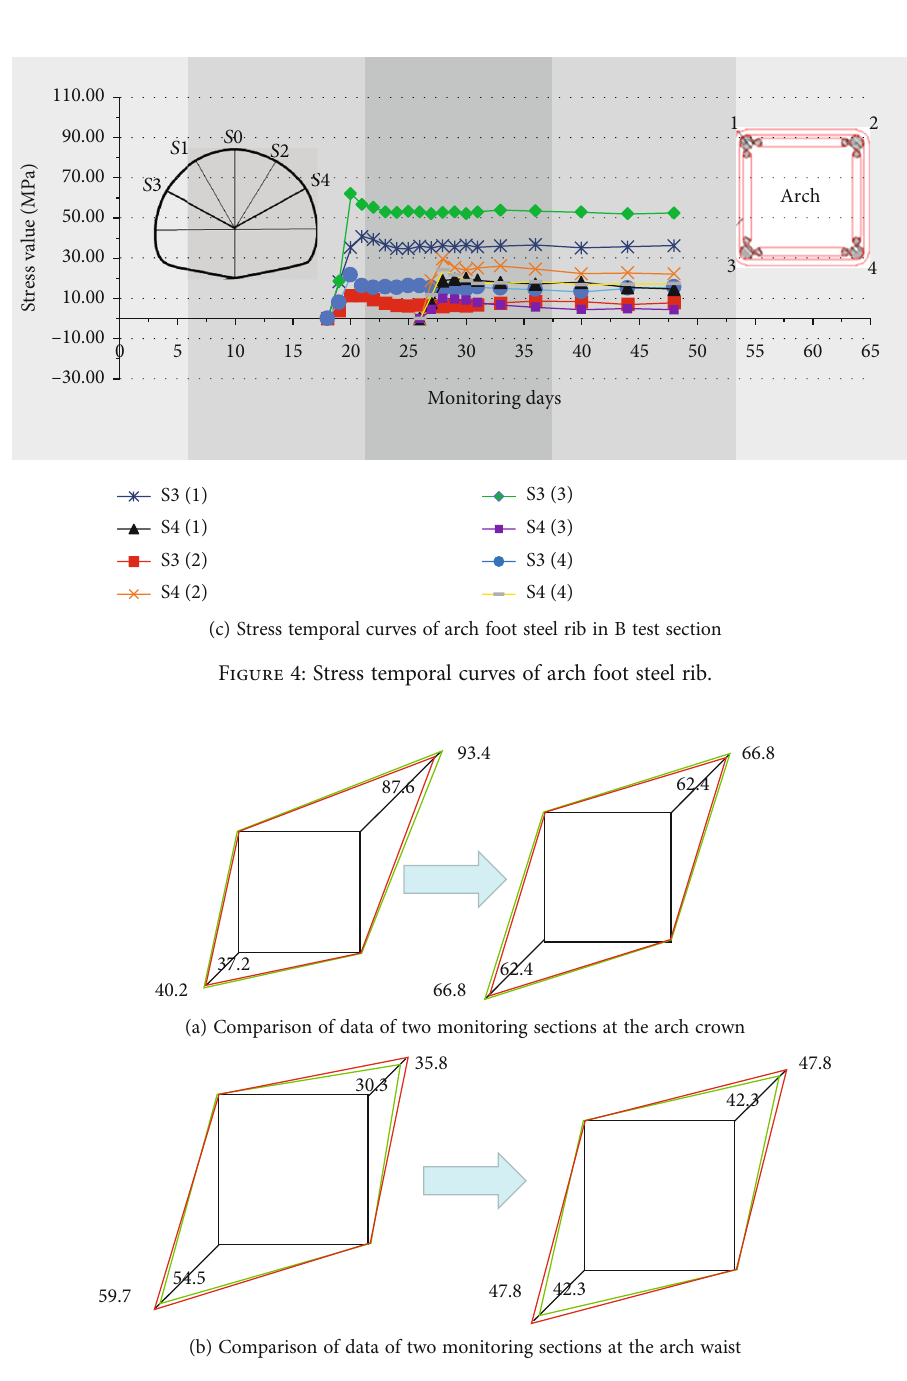
Figure 5: Comparison of data of two monitoring sections (Unit: